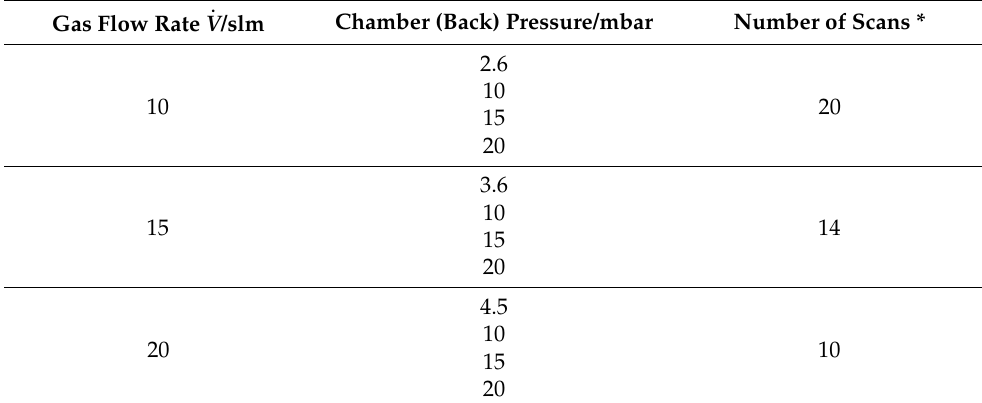
Table 1. Parameter sets for flow imaging and film